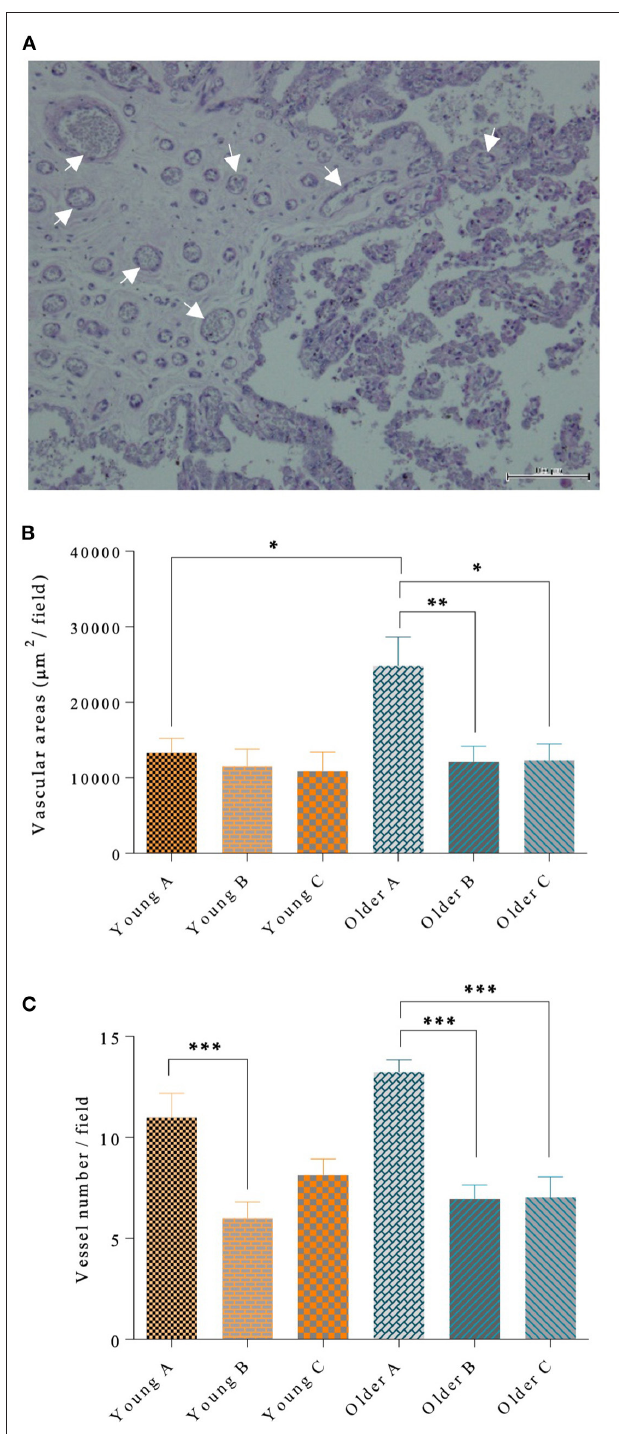
FIGURE 5 | Blood vessel walls stained by PAS (some marked with arrows), in mare placenta (A) . In (A) , bar = 100 µ m. In the left half of the image, the chorion is depicted, with the chorionic plate enclosing vessels, and the trophoblast (simple cuboidal epithelium whose cells possess a basophilic cytoplasm) lines the chorionic plate. In the right half, the chorionic villi can be seen, externally covered by trophoblasts and with the axis composed